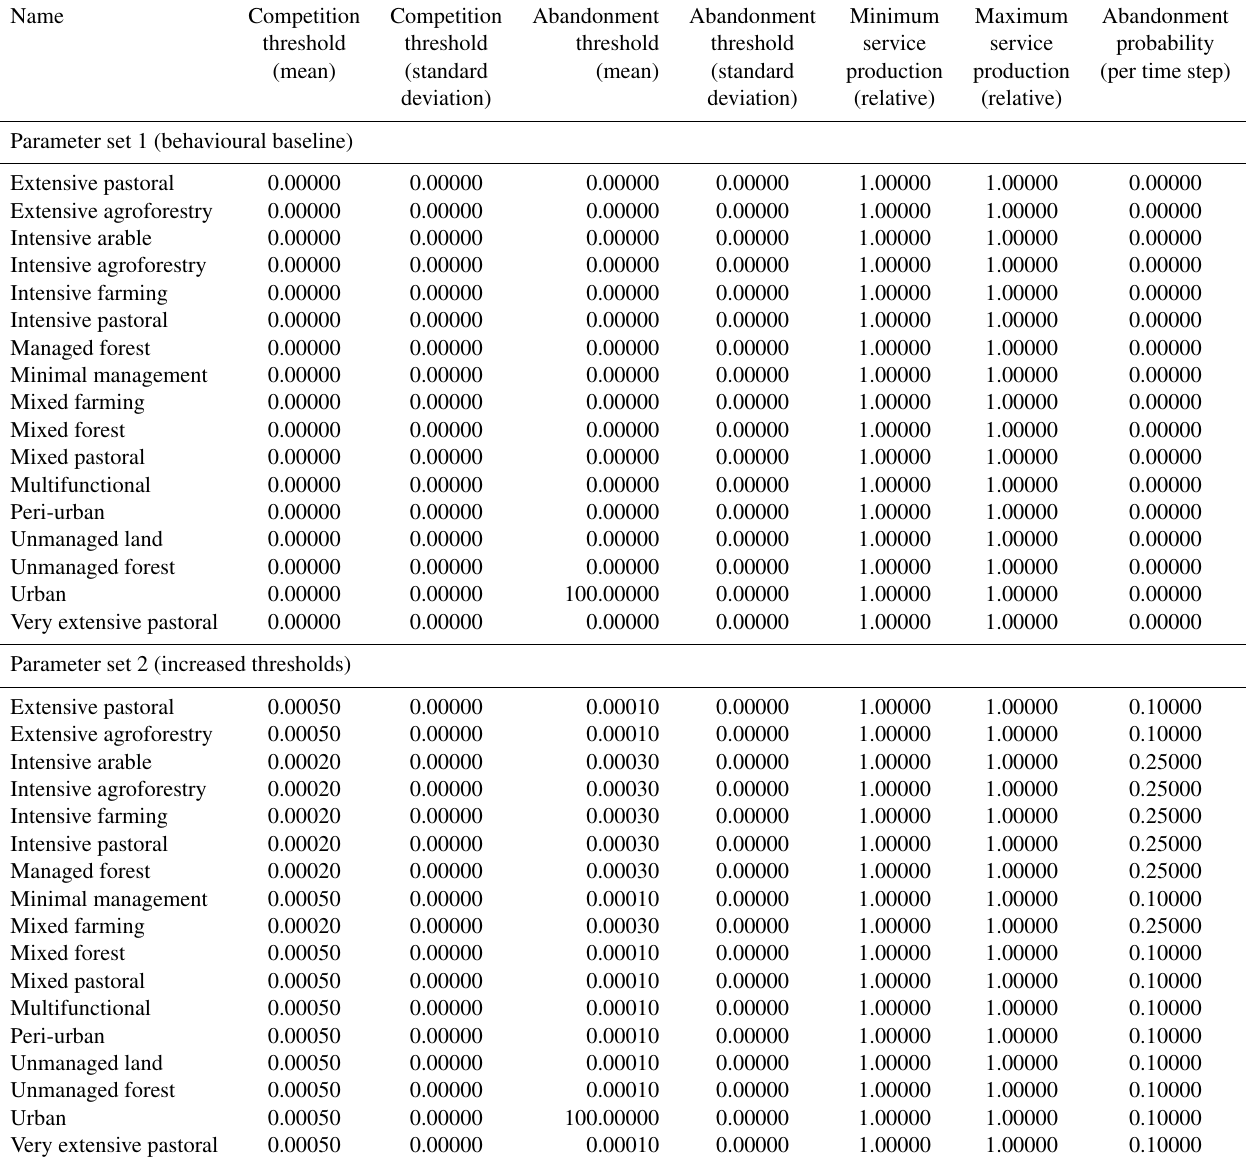
Table A4. Behavioural parameter variations used in the simulations. Parameter set 1 is the default from which main results are derived; in this setup agents respond directly to benefit values with no additional individual or typological behaviour. In parameter set 2, abandonment and competition thresholds are altered to introduce abandonment of land when benefit values fall below the abandonment threshold value and resistance to change unless a competing land use has an additional benefit value of at least the competition threshold. Intensive land use agents are parameterised to be less tolerant of low benefit values and more willing to switch to a land use with higher benefit values. In parameter set 3, individual agents differ from one another in terms of their abilities to produce different ecosystem services as well as their abandonment and competition thresholds. Parameter sets 4 and 5 replicate parameter sets 2 and 3, respectively, but with larger values for thresholds and variations, with threshold values of up to approximately 100% of mean benefit